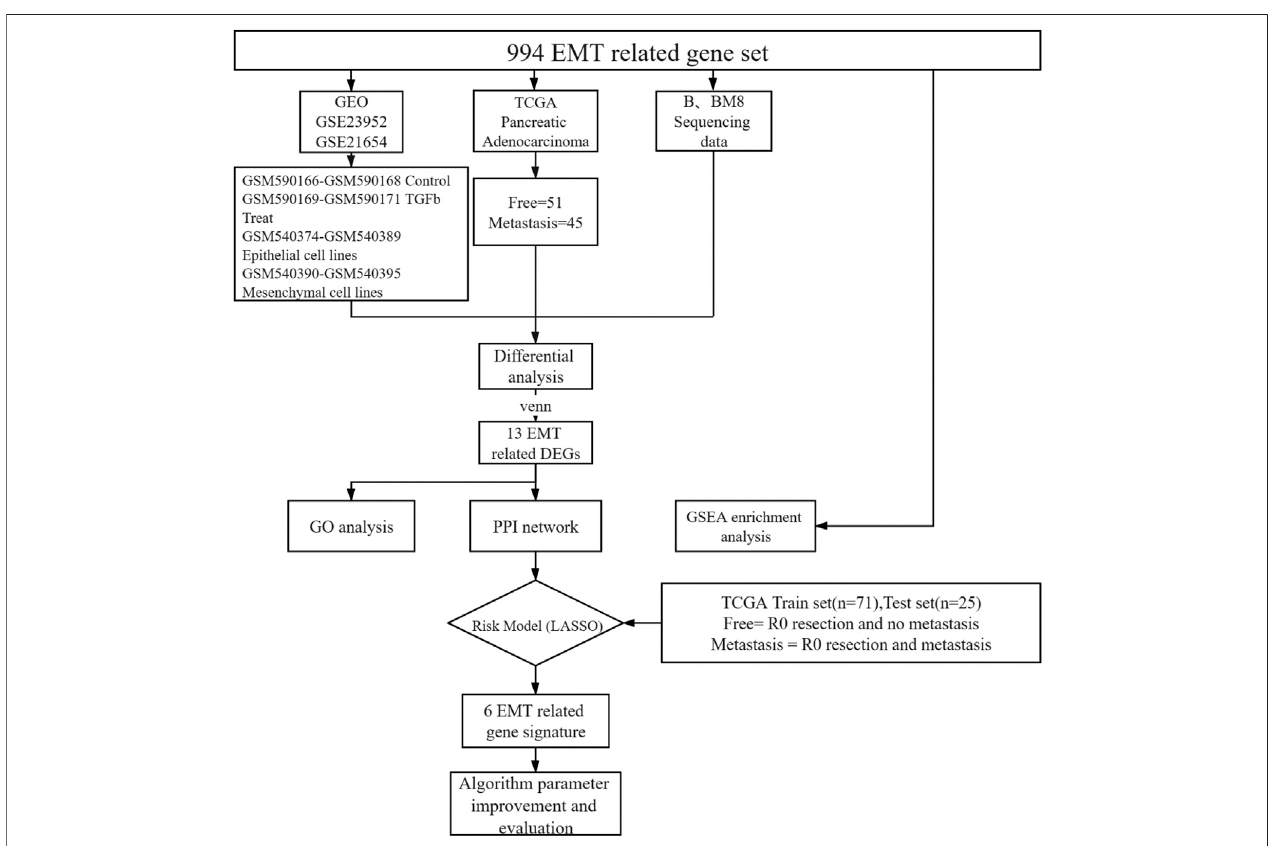
FIGURE 1 | Schematic representation of the process followed in this